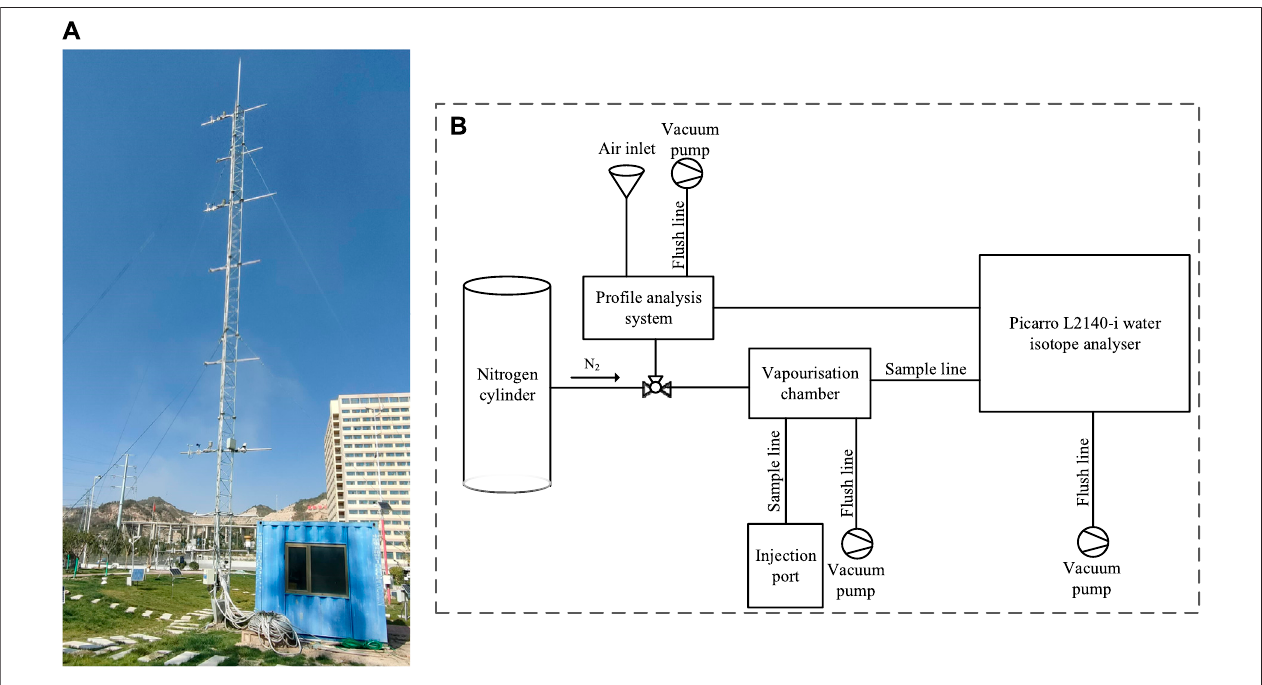
Agency (IAEA) and selected LGR-2E and LGR-5E as standard materials. The measured and true values of the hydrogen and oxygen isotope standard samples are listed in Table 1 . The X-coordinate axis was the measured value of the Picarro L2140-i isotope determination standard substance, and the Y-coordinate axis was the true value of the standard substance. A scatter diagram and trend line could then be obtained. By substituting the measured values of atmospheric water vapor and precipitation isotope into the linear equation, the true value of the sample in this experiment was obtained. standard sample measurement was established for two months to correct the measured data of meteoric water vapor and precipitation during this time period. All the samples were inputted into the American Picarro L2140-i water isotope analyzer which simultaneously measured δ 18 O, δ 17 O, and δ 2 H in liquid and gaseous water. We used the conventional δ notation to report isotope data (Craig, 1961; Merlivat and Jouzel, 1979):